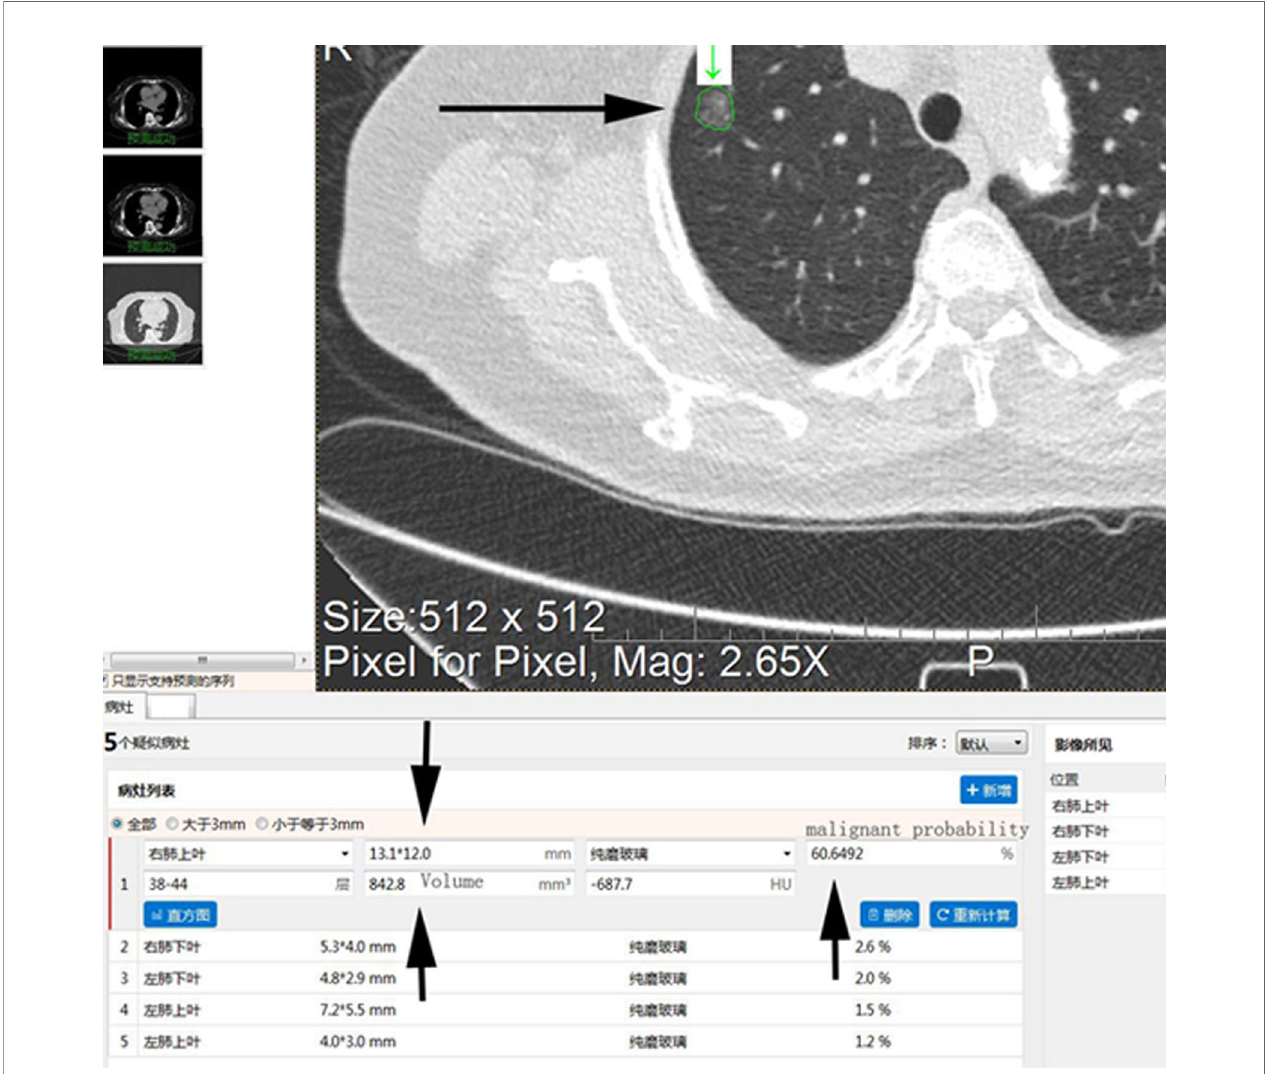
FIGURE 2 | Screenshot of AI-assisted diagnostic software in the analysis of a speci fi c CT image. The long arrow shows the analysis of an LDCT image in which all detected nodules have been marked. The short arrow indicates detailed information regarding the underlying nodule (e.g., location, maximum diameter, minimum diameter, density type, malignancy probability, volume, mean CT value). AI, arti fi cial intelligence; LDCT, low-dose computed tomography; CT, computed